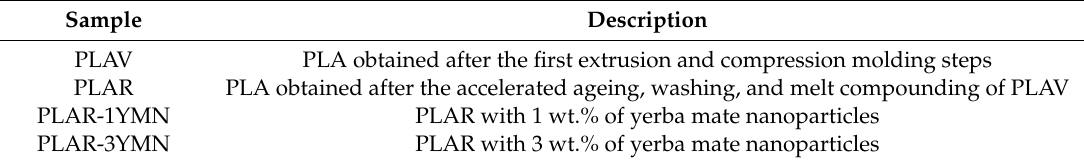
Table 1. Materials obtained after the recycling process.